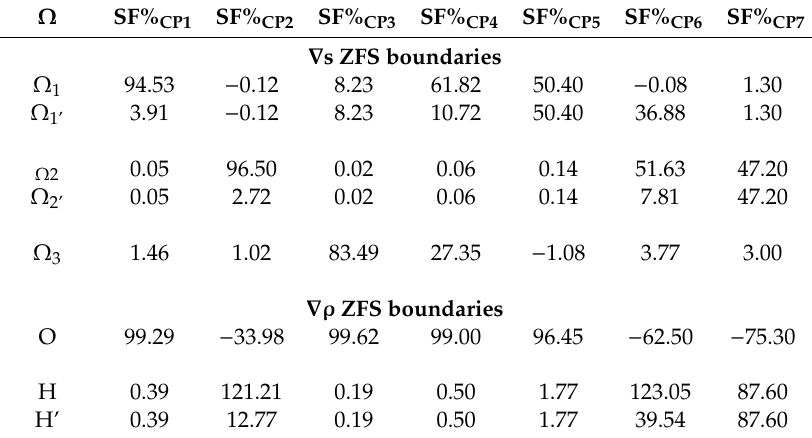
Table 5. 3 B 1 H 2 O molecule: Source Function percentage contributions (SF%) to the electron spin density CPs for various Ω Basin types 1